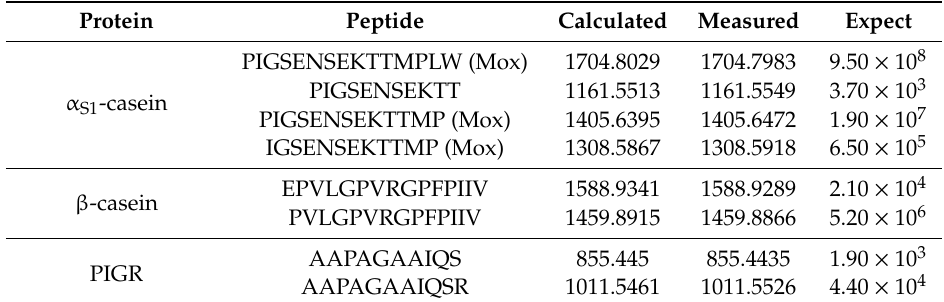
Table 2. Milk peptides transported over porcine brain endothelial cell (PBEC) monolayers (Blood Brain Barrier model) identified by LC-MS /